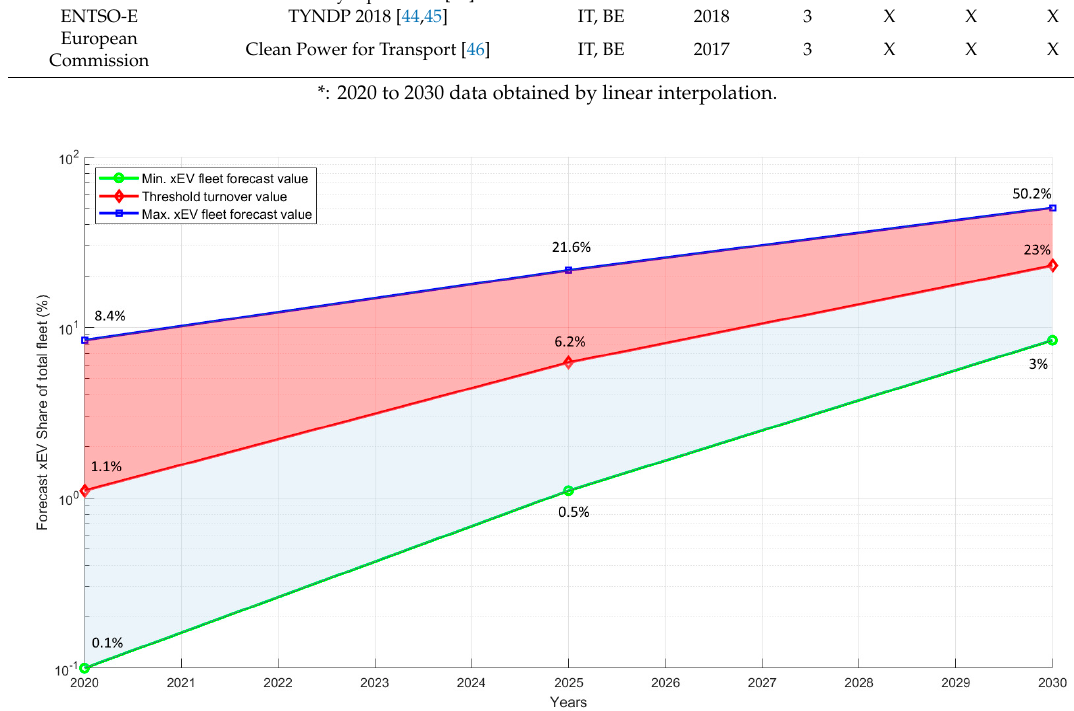
Figure 8. xEV fleet growth forecast—total range of collected data values and highlight of the selected part (light blue), under threshold limit (red line).